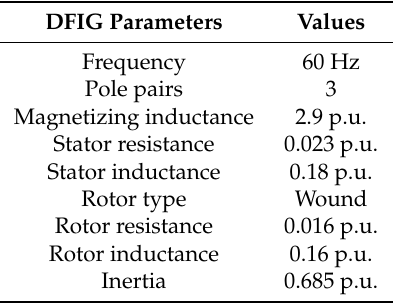
Table 2. Parameters of the 1.5-MW doubly fed induction generator (DFIG) model